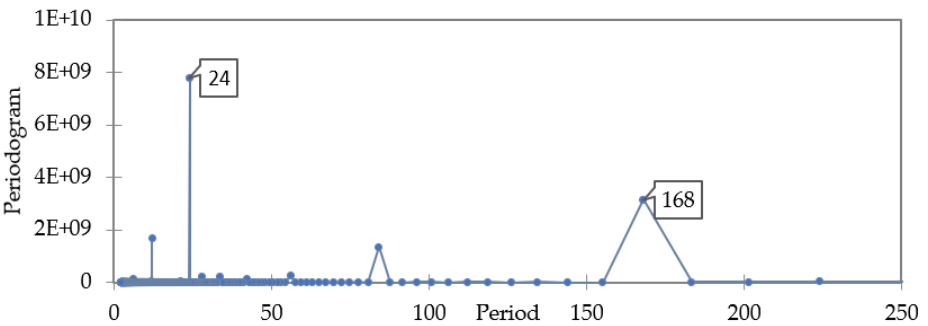
Figure 4. Periodogram of the load data time series.